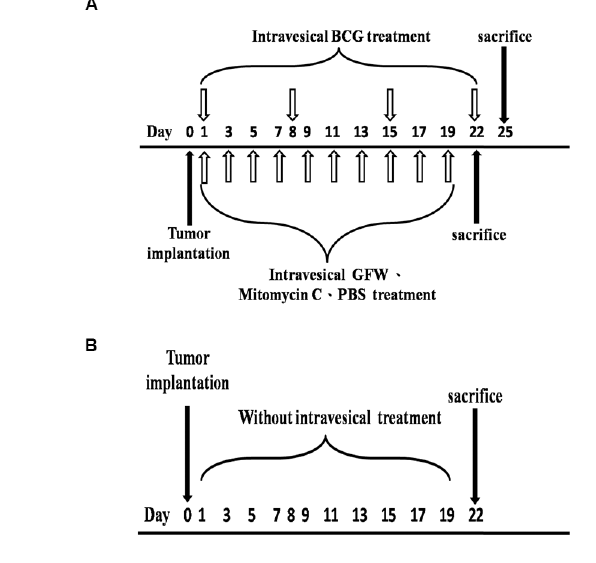
Figure 1. Strategy used in intravesical treatment in a murine orthotopic bladder tumor model. Time schedules of treatment groups (A) and nontreatment control groups (B) are shown. Twenty-four hours after tumor implantation, animals in the treatment group underwent intravesical therapy with 100 μ L GFW (180 mg/mL), 100 μ L Mito-C (0.4 mg/mL) or PBS every other day (empty arrows pointing up), or 100 μ L BCG (1 × 10 8 CFU/3 mL) therapy every week (empty arrows pointing down), while the control group received no